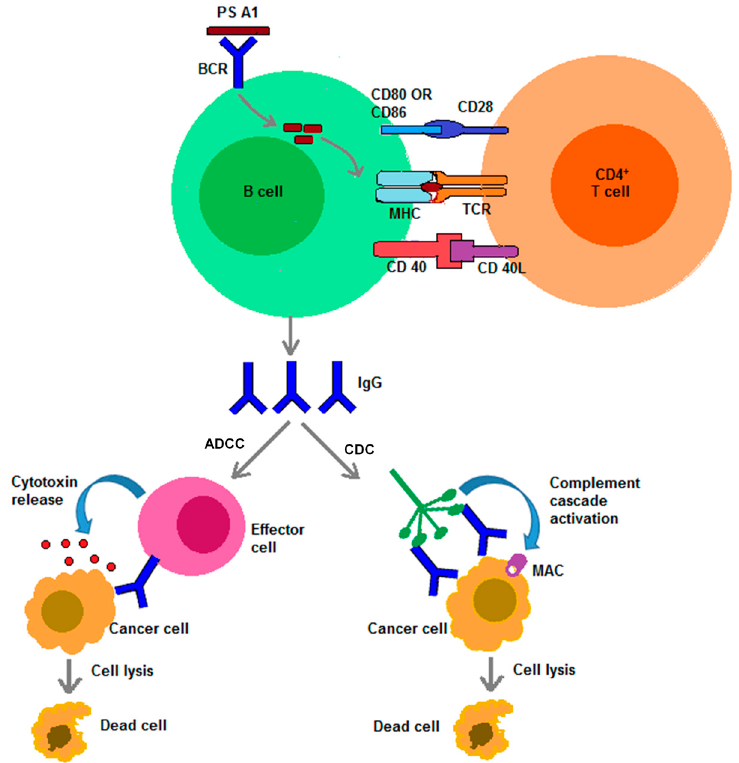
Figure 1. Cancer cell death through immune cytotoxicity (ADCC and CDC).